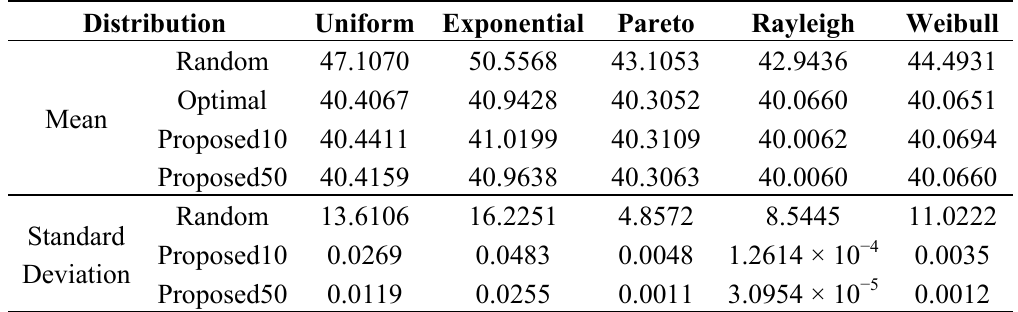
Table 3. Performance comparison (Case A). Note that “Proposed10” and “Proposed50” stands for “Proposed algorithm with 10 iterations” and “Proposed algorithm with 50 iterations”,